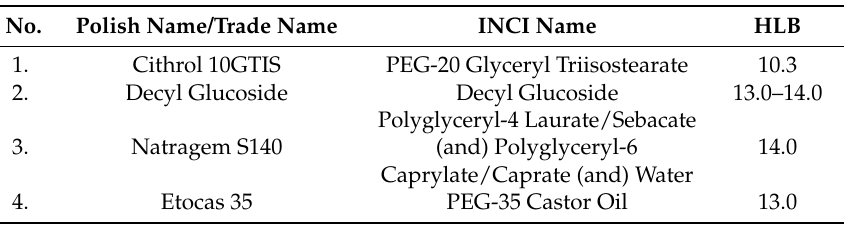
Table 1. Emulsifiers used in the